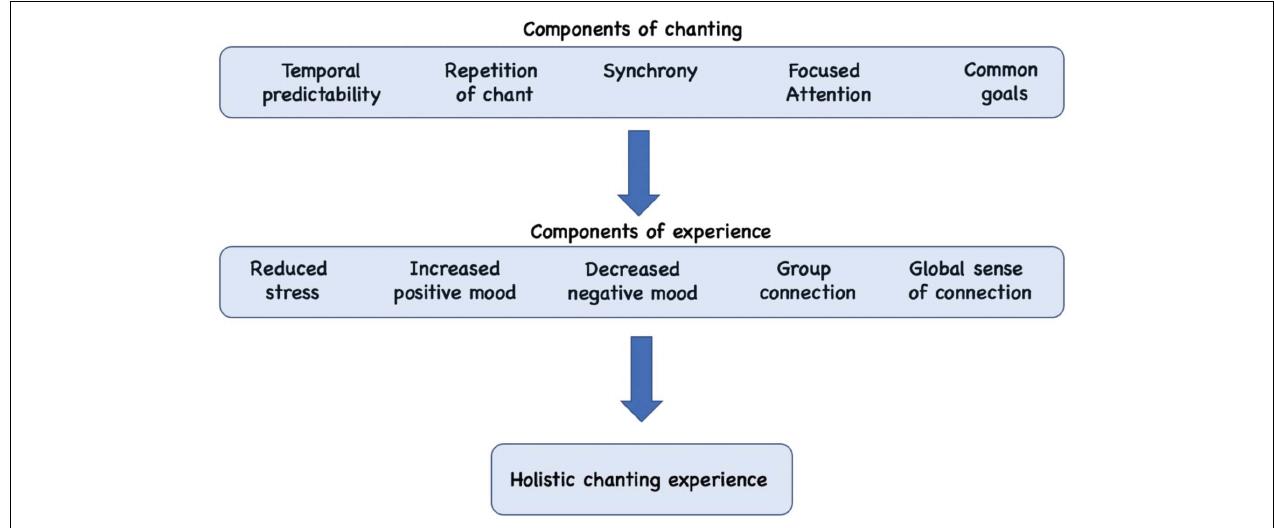
FIGURE 1 | Various components of chanting converge to confer psychosocial benefits, including reduced stress, elevated mood, and increased feelings of social connection.